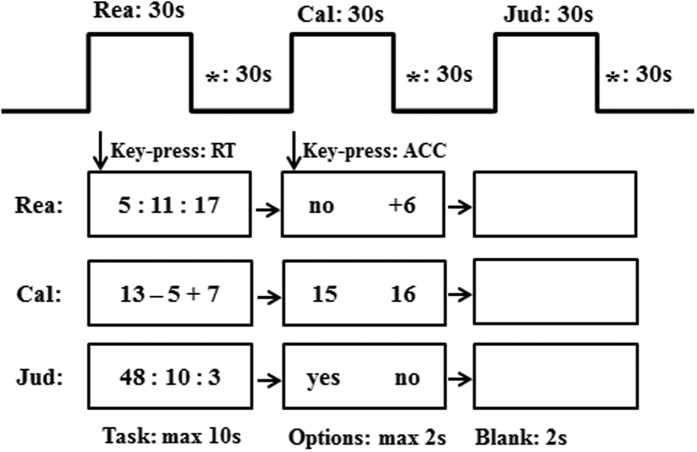
Schematic representation of the fMRI procedure.The three types of problems (Rea, Cal, and Jud) were administered in a run. The order of blocks was randomized with constraint of no more two the same block appeared consecutively.